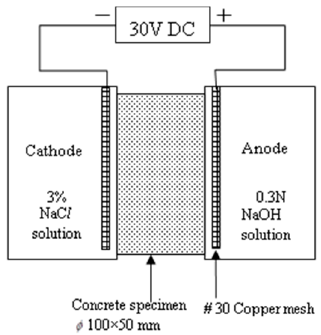
Figure 2. Schematic illustration of rapid chloride penetration test.